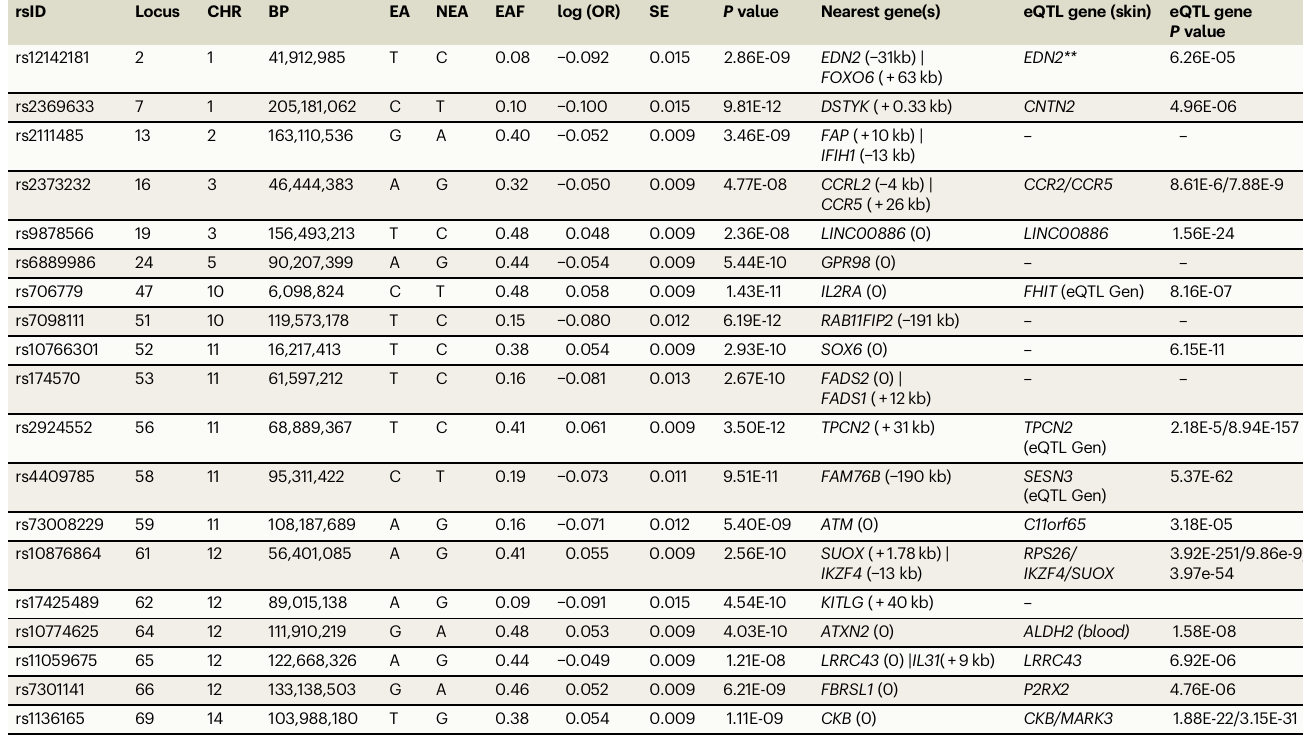
Table 1 | BCC susceptibility novel loci that replicated at P < 0.05 in 23andMe cohort rsID Locus